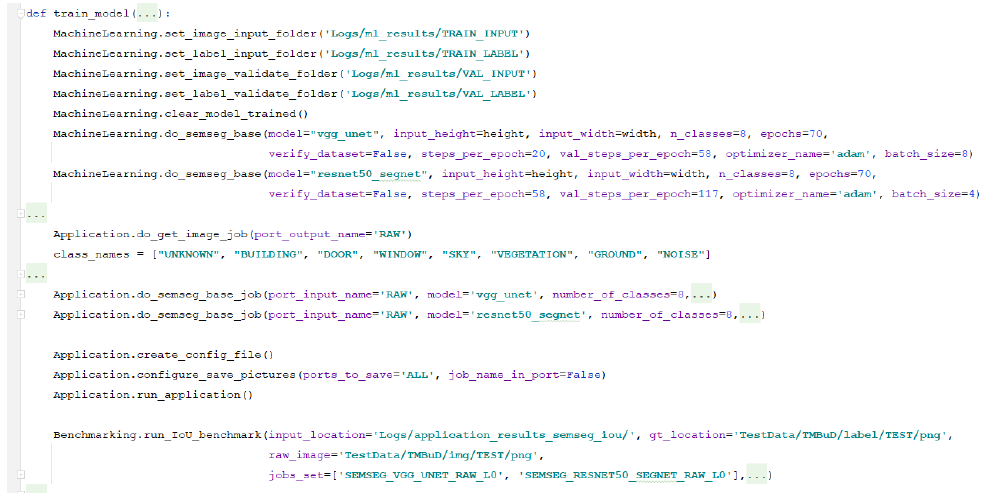
Figure 14. Code snipe of training semantic segmentation models.